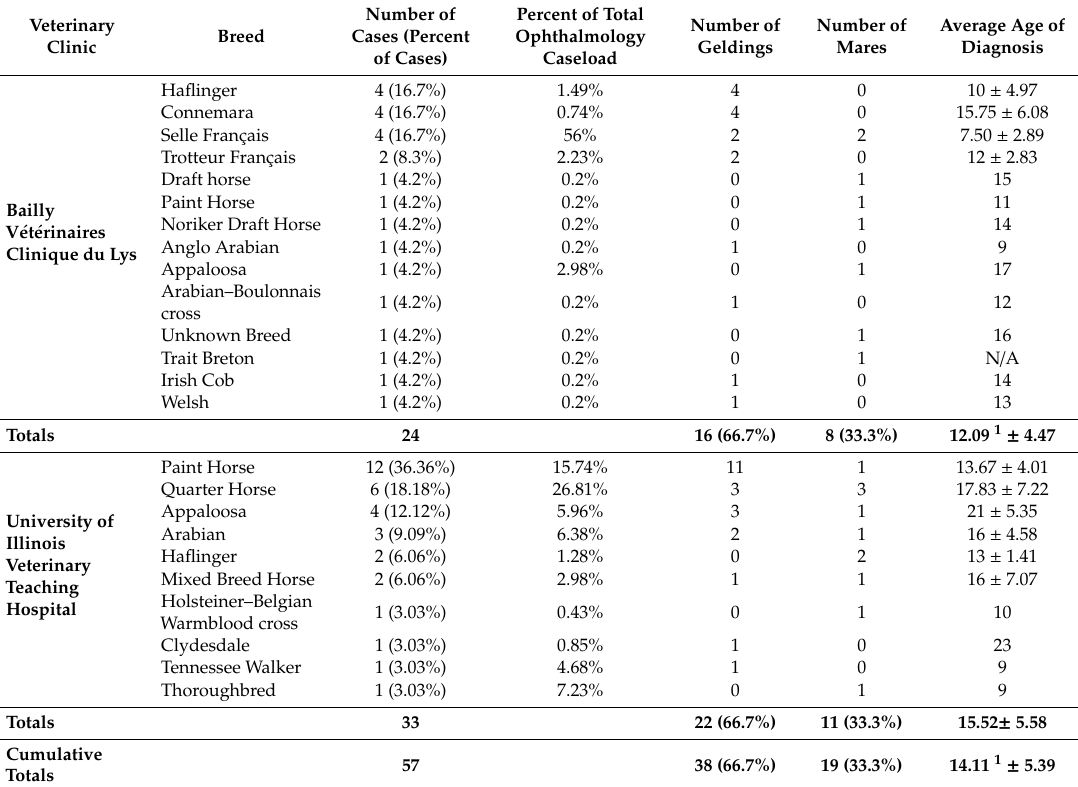
Table 1. Retrospective breed distribution of ocular squamous cell carcinoma (SCC) cases at two veterinary